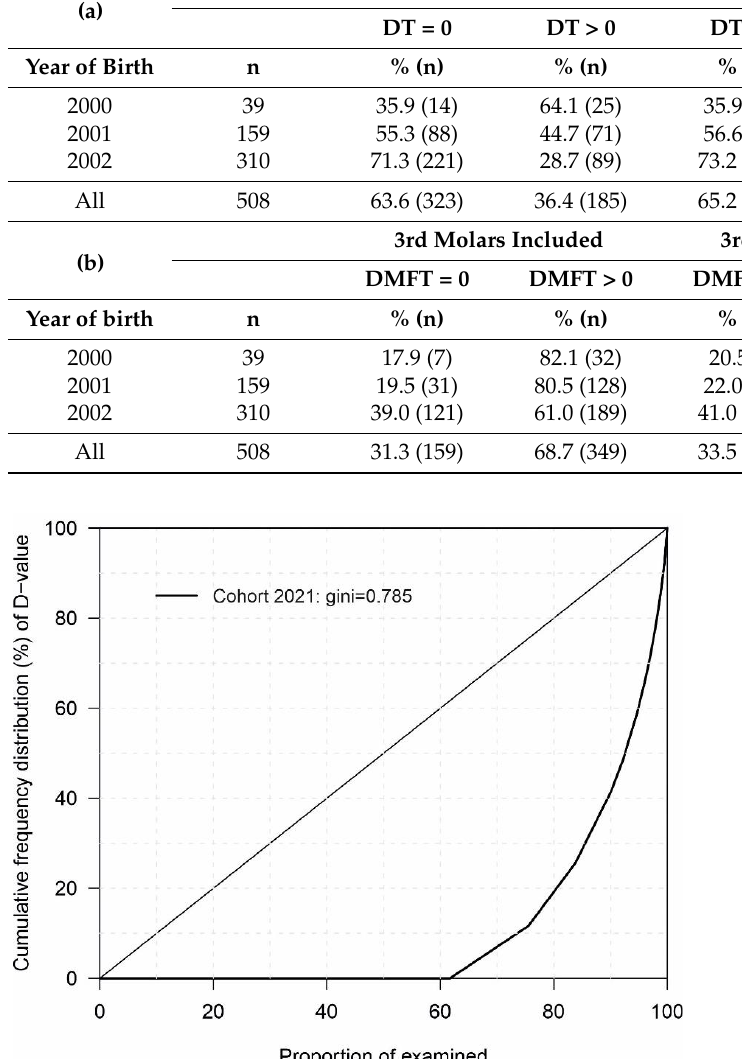
Figure 1. Polarization and concentration of caries burden among Finnish conscripts (Lorentz curve) 2021.